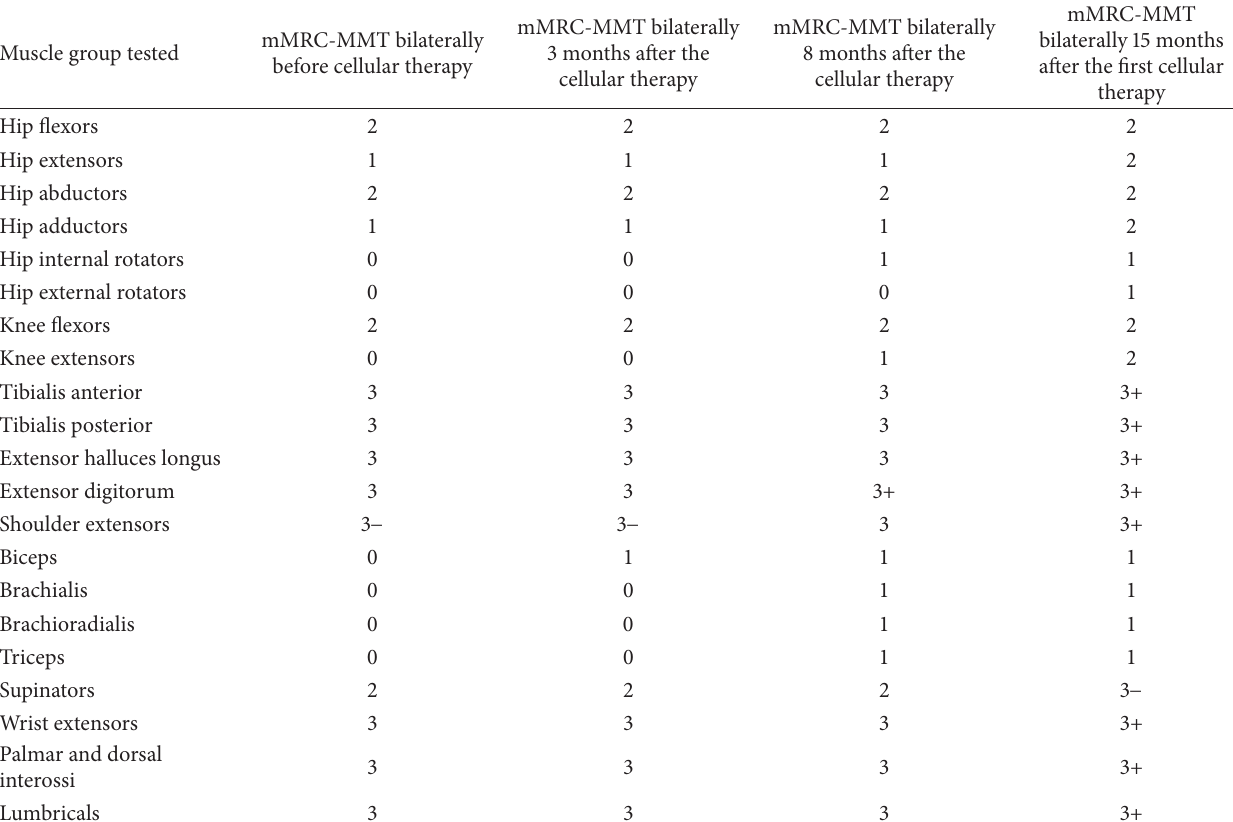
Table 3: Changes in the muscle strength over fifteen months after the first cellular transplantation.